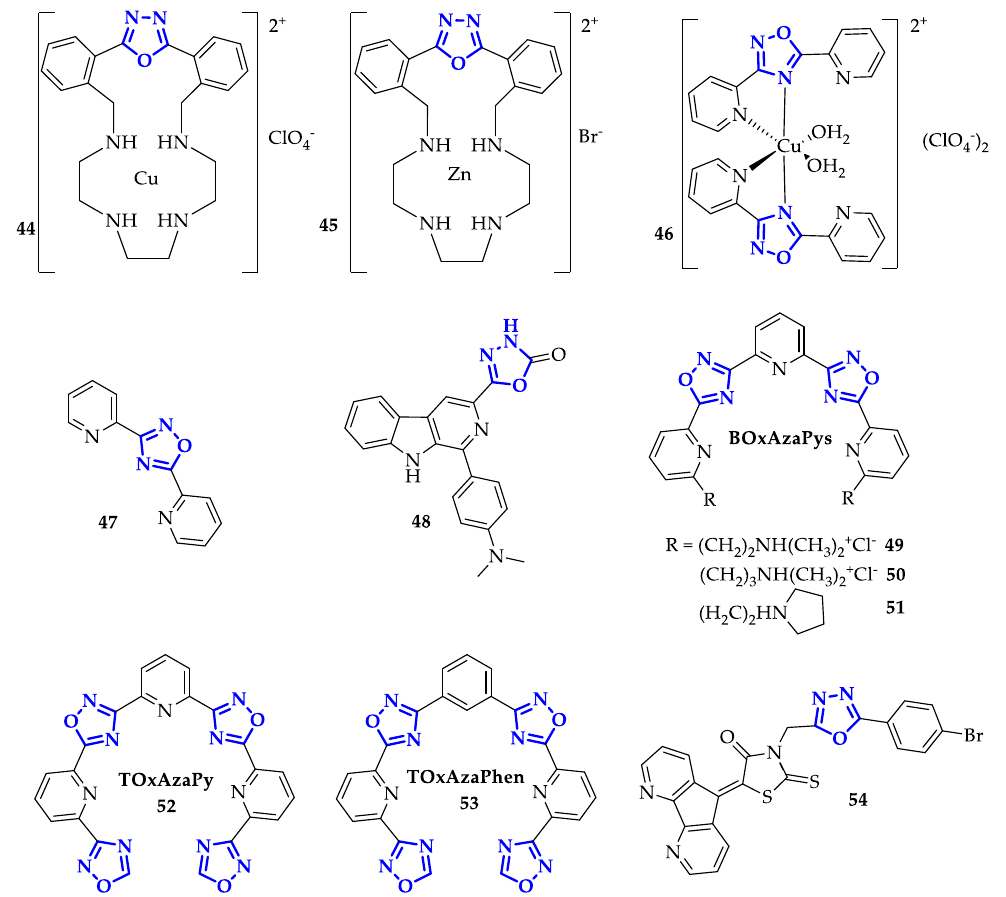
Figure 9. Nucleic acid ligands containing oxadiazole moieties.